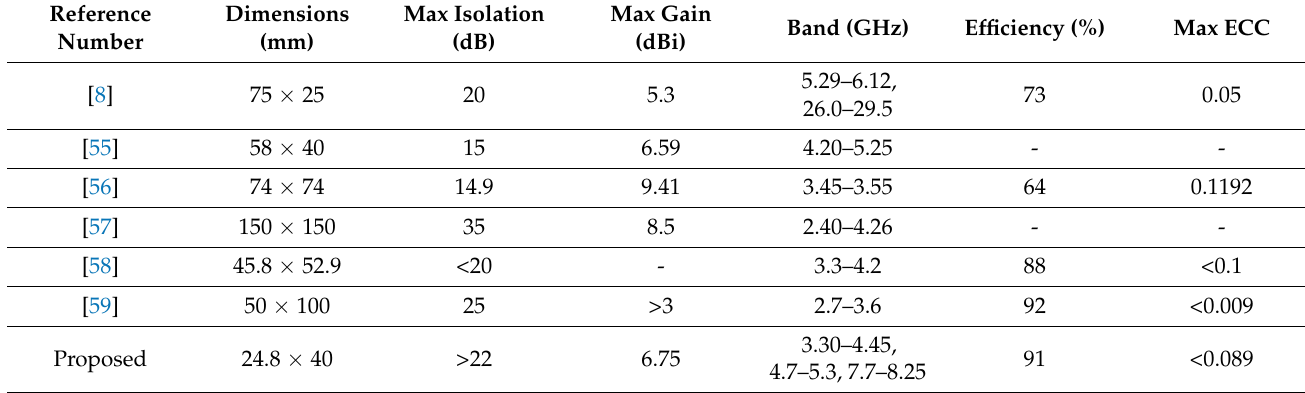
Table 6. Comparison between a few reference antennas and the proposed antenna for 5G communication.